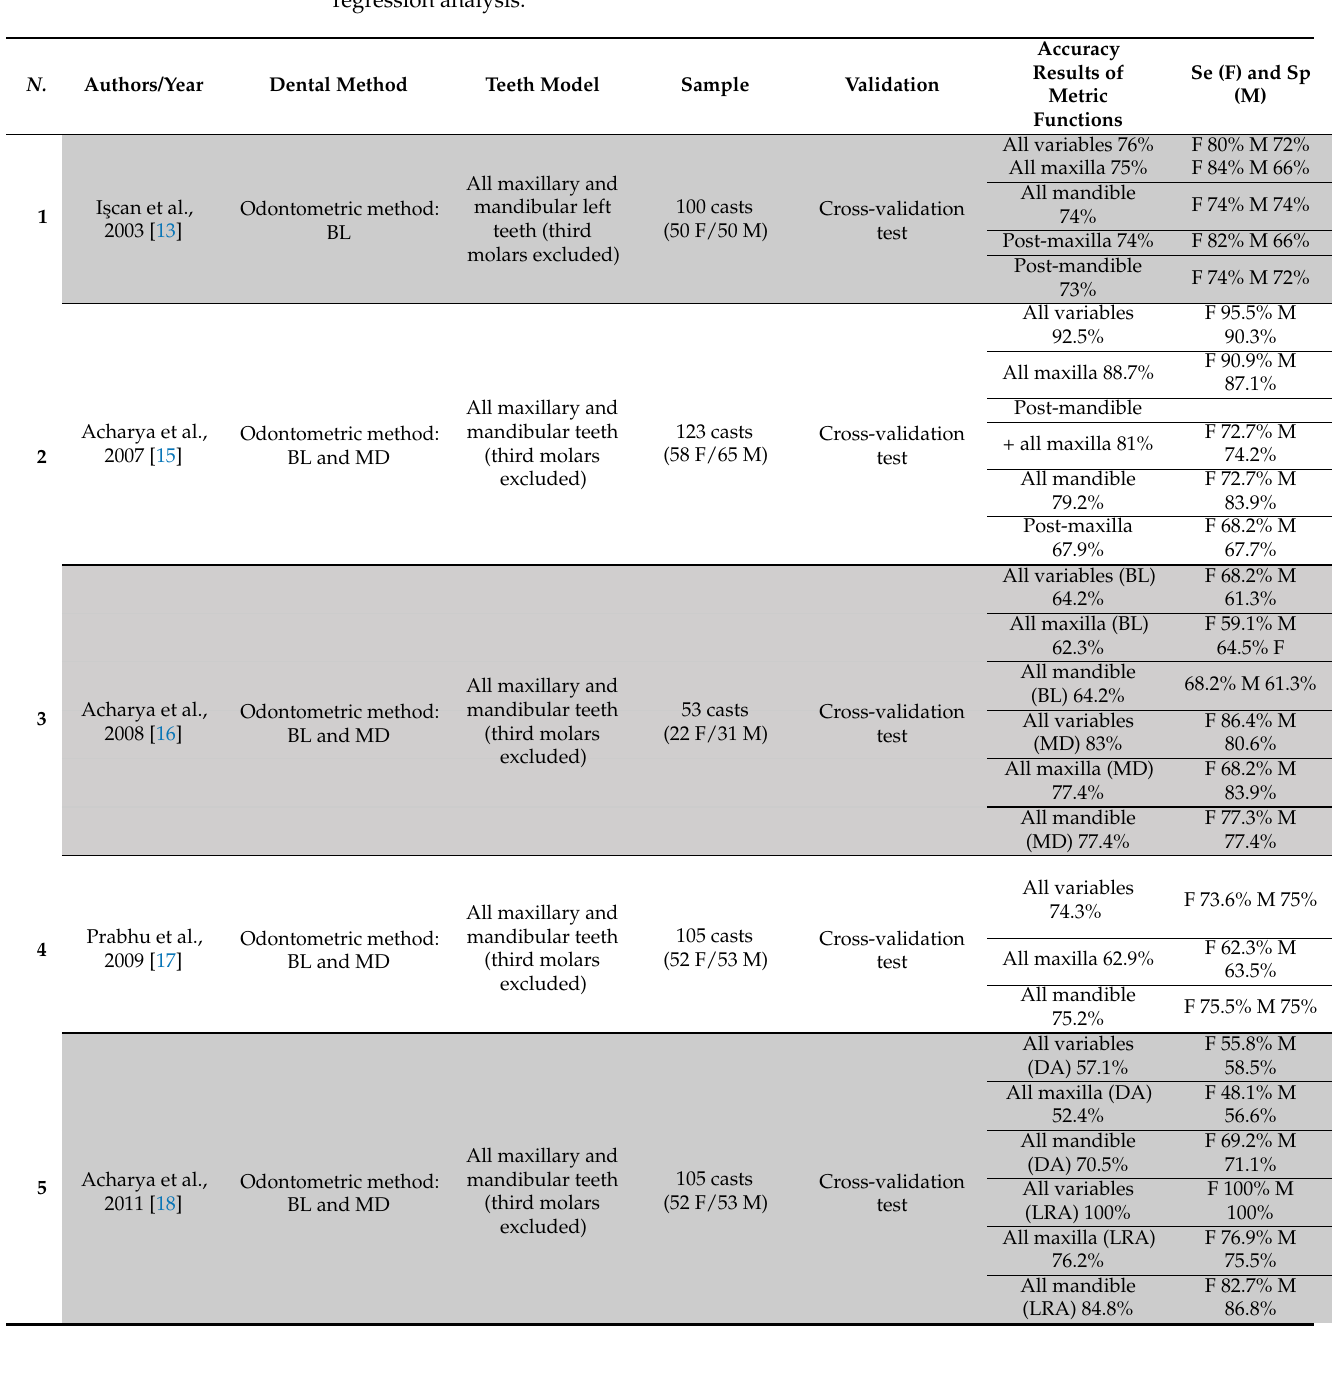
Table 3. Odontometric methods (1–8) and morphometric dental methods (9–10) for sex classification. Acc: accuracy results of metric functions; Se: sensitivity; Sp: specificity; post-maxilla: posterior mandibular teeth (lower first and second premolars and first and second molars); post- maxilla: posterior maxillary teeth (upper first and second premolars and first and second molars); BL: